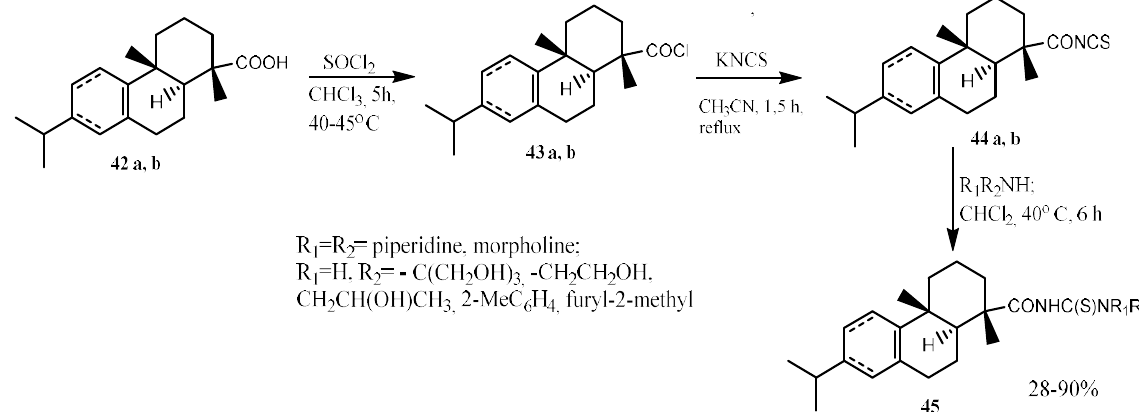
Fig. 14. Approaches to the synthesis of asymmetrically disubstituted acyl thioureas with dihydrophenatrene